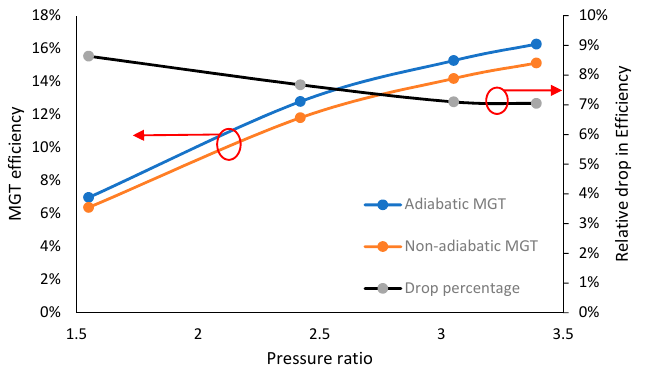
Figure 7. MGT adiabatic and non-adiabatic efficiency at different operating conditions and the relative drop in efficiency when considering heat transfer in the calculations.